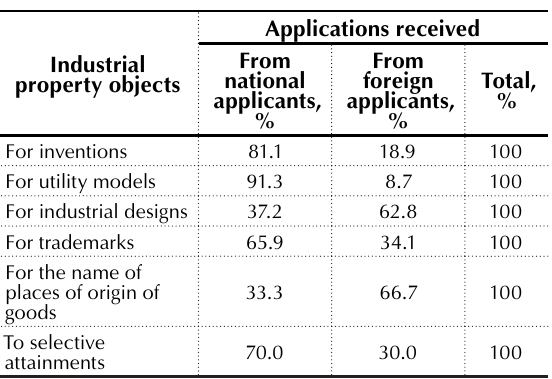
Table 6. Information on applications submitted to RSE “NIIS” for the issue of titles of protection for industrial property in